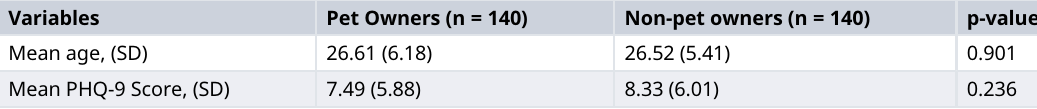
Table 1. Mean and standard deviation of participant age and PHQ-9 score.